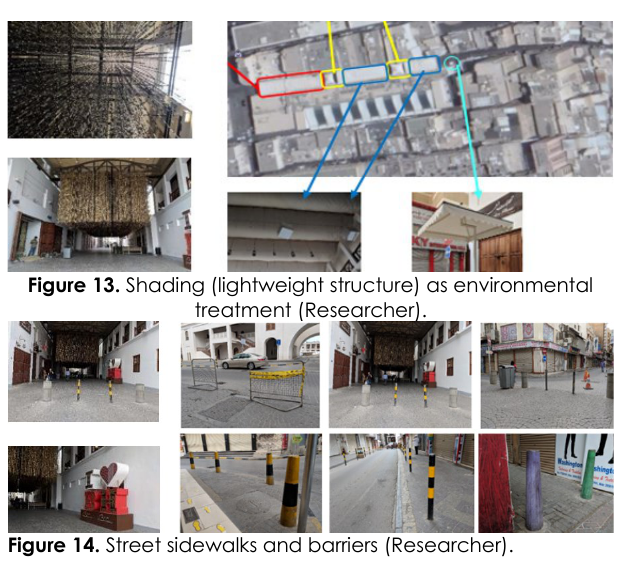
Figure 12. Lighting elements (Researcher).